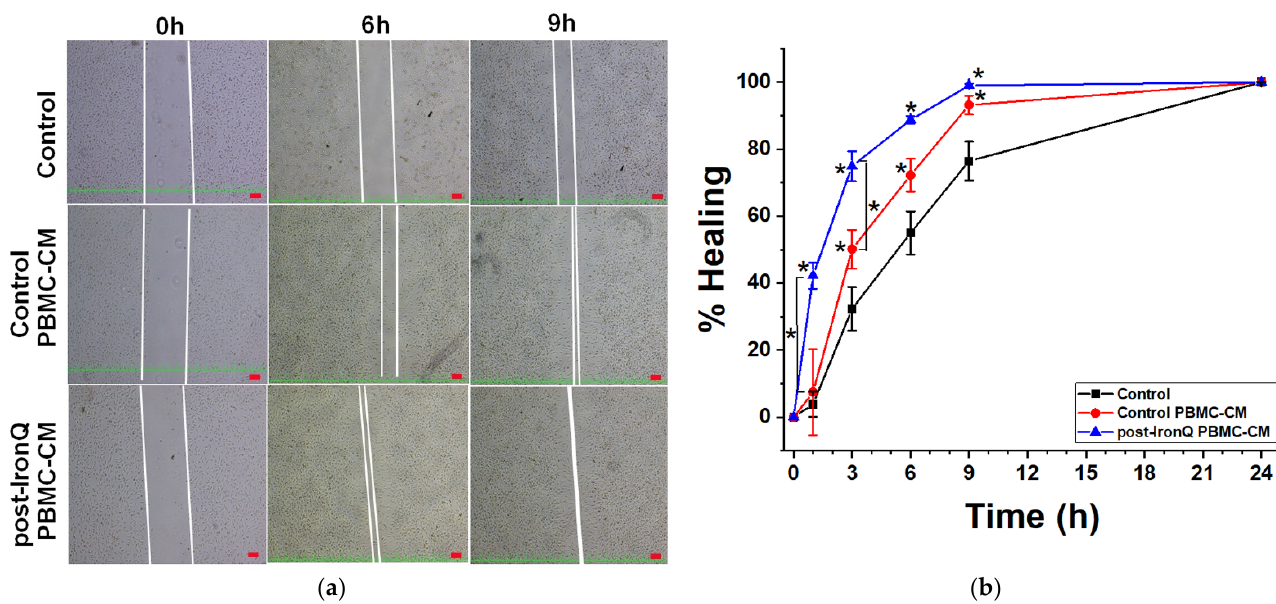
Figure 6. Effects of the conditioned medium of IronQ-preconditioning PBMCs on fibroblast migration in a wound scratch assay. ( a ) Representative images of scratch assays of L929 fibroblasts immediately after the scratches had been made (0 h) and then after 6 and 9 h in the presence of PBMC-CM, versus ordinary medium. Scale bar = 100 µm. ( b ) Scratch closure was measured as the width of each scratch using Image J software. Each time point was normalized to the image perimeter at 0 h, and reported as a percentage of healing. The results are expressed as means ± SD ( n = 8). * p < 0.05.